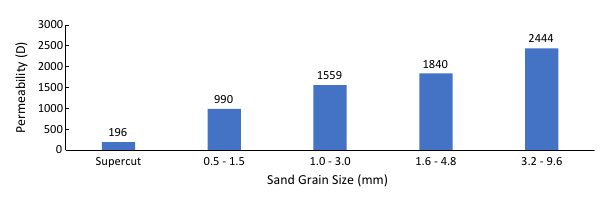
Fig. 3 Sample of pressure